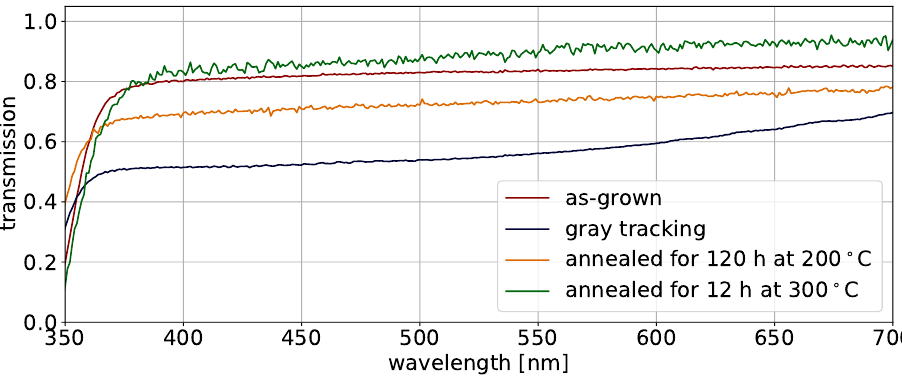
Figure 4. Comparison of the optical transmission of an as-grown sample (red line), gray-tracked sample (dark blue line), for 120 h at 200 ◦ C annealed sample (orange line) and for 12 h at 300 ◦ C annealed sample (green